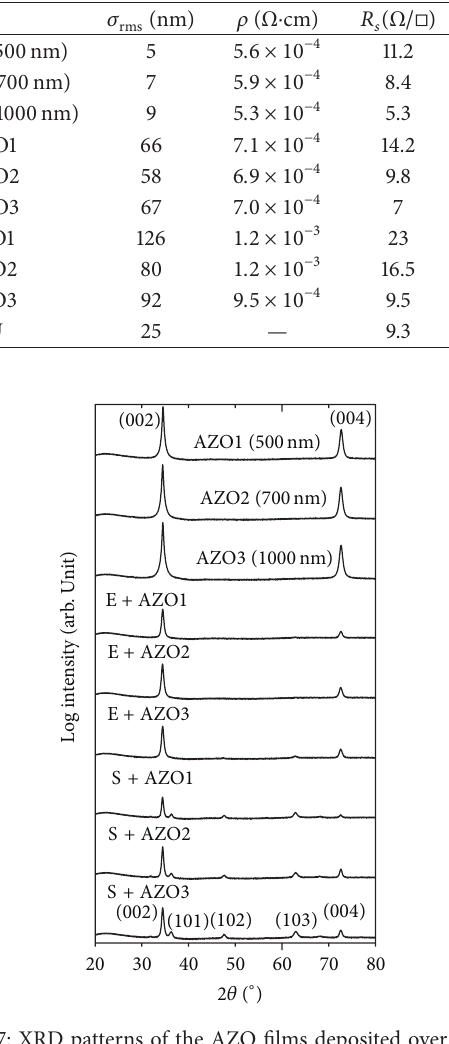
Figure 7: XRD patterns of the AZO films deposited over smooth and textured